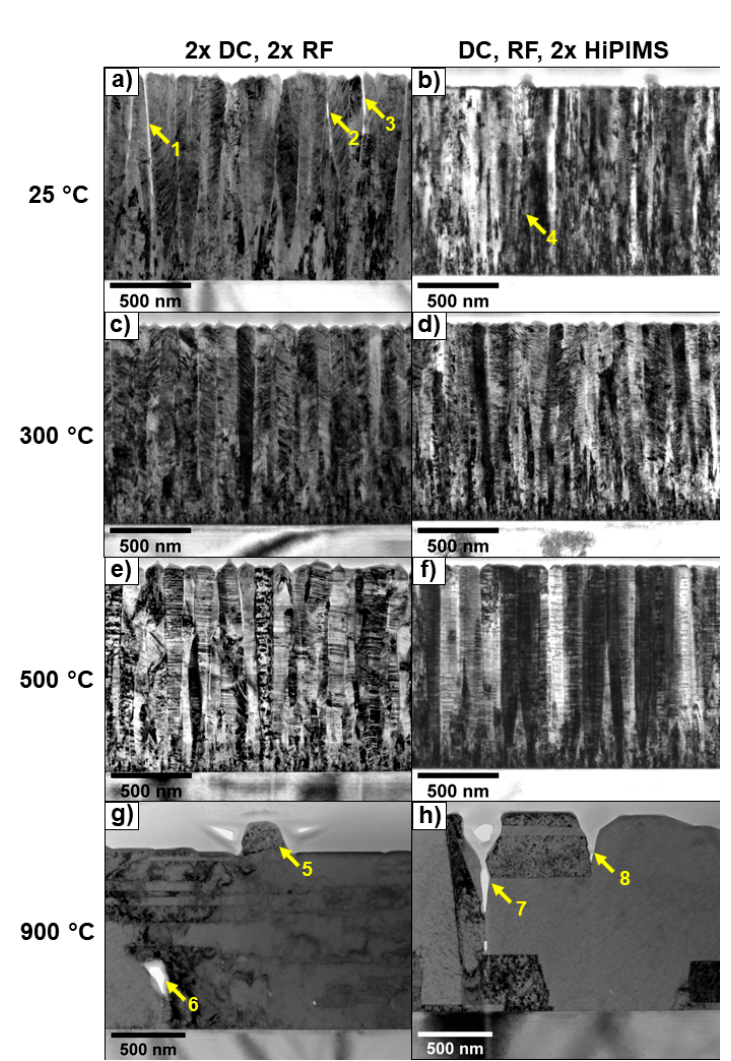
Figure 4. TEM images of focused ion beam (FIB) cross sections of CoCrFeNi films deposited at different process parameters. The left column films ( a , c , e , g ) were grown with two cathodes powered by DC and two cathodes powered by RF generators. The right column films ( b , d , f , h ) had cathodes powered by one DC, one RF, and two HiPIMS generators. Substrate temperatures during growth for each condition are indicated for each row. ( a ) Details 1, 2, and 3 highlight voids originating between grains. ( b ) Detail 4 indicates the origination of one of the abnormal surface features. ( g ) Detail 5 shows a large surface protrusion, and detail 6 shows an internal void. ( h ) Details 7 and 8 indicate intergranular grooves.